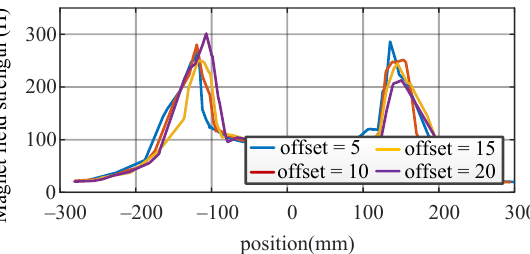
Figure 31. Magnetic field strength curves with the proposed structure and different offsets of the